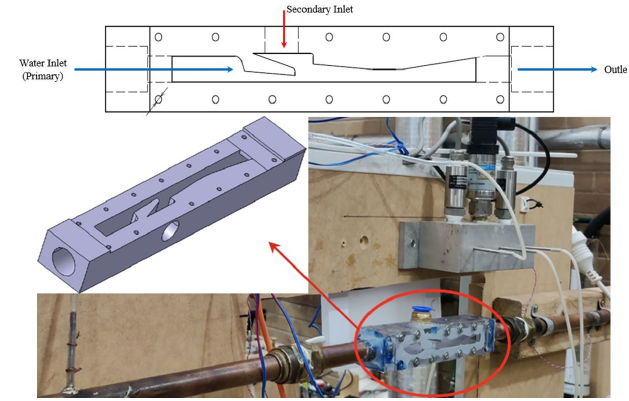
Figure 11. 3D printed transparent